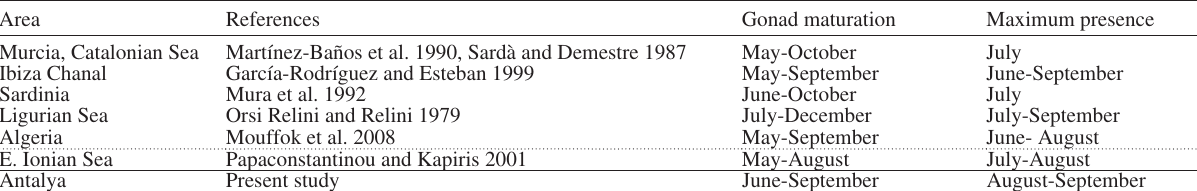
Table 5. – Reproductive pattern of A. antennatus in various Mediterranean